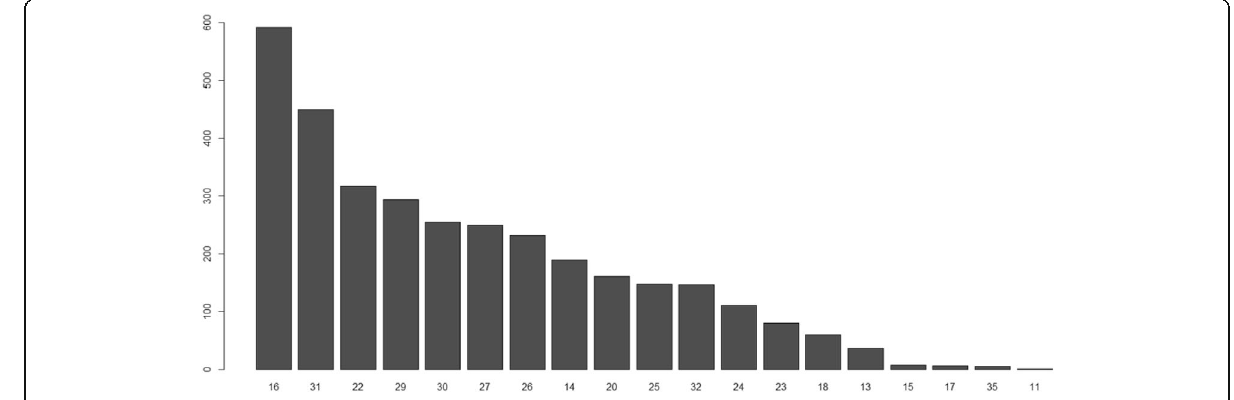
Fig. 2 Number of service stops for each vehicle in May 2017 (vehicle IDs on the